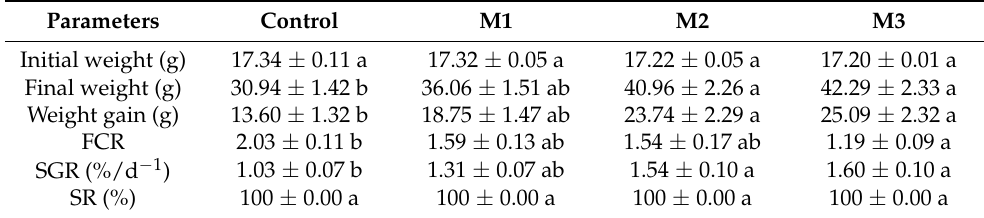
Table 2. Growth performance of C. carpio fed four diets incorporated with zero (control), 0.5% (M1), 1% (M2), and 2% (M3) of Myristica fragrans for four weeks. Parameters